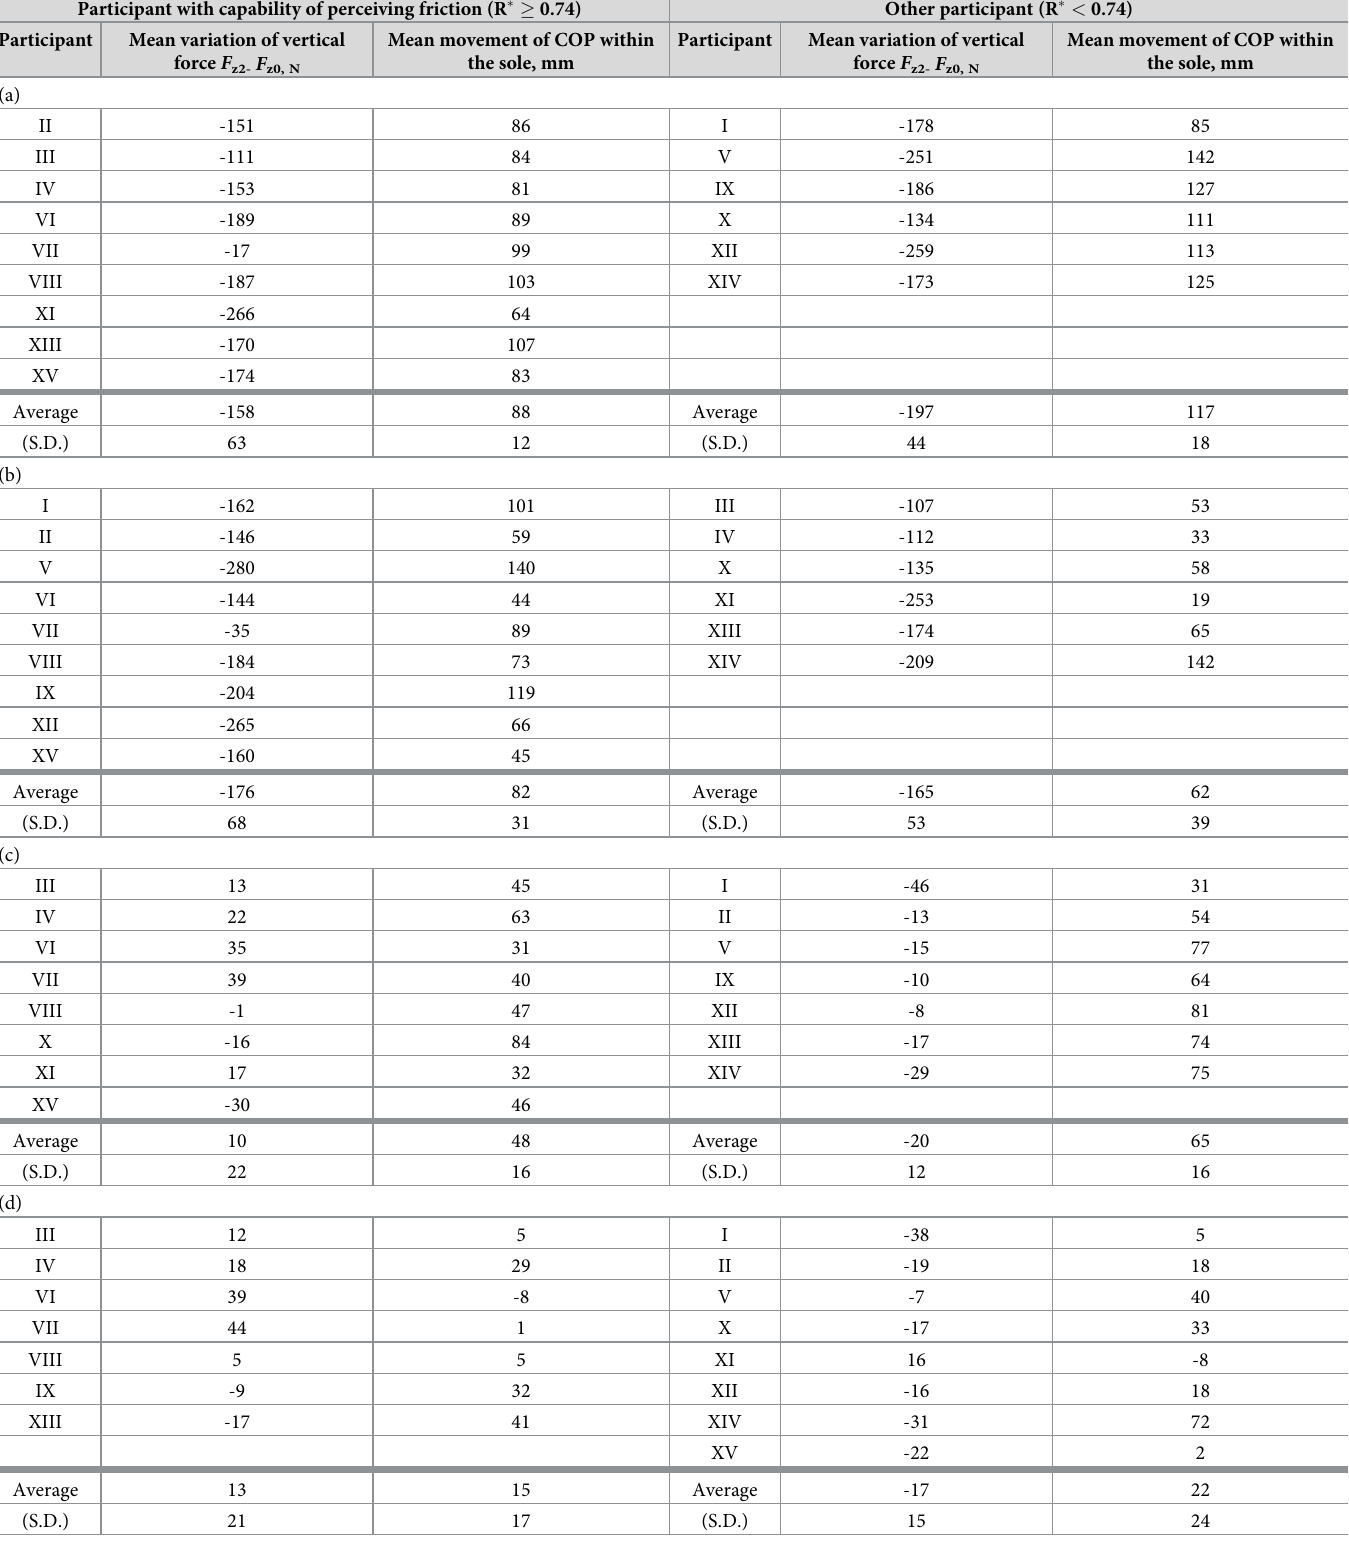
Table 8. Mean variation of vertical forces and mean local movements of COP within sole. (a) Slip onset while standing. (b) Sliding while standing. (c) Slip onset while sitting. (d) Sliding while sitting. Participant with capability of perceiving friction (R � �